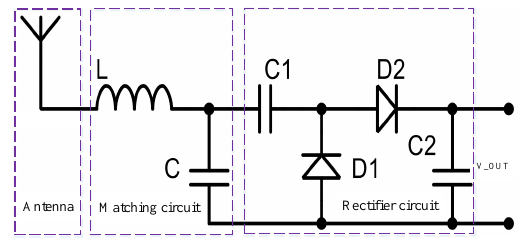
Figure 4. The scheme of the RF energy harvesting The antennas of the RF harvesting system capture the ambient radio frequencies in the environment. The densities of the radio frequencies are the main factor direct-a ff ecting the harvesting energy. Nowadays, the high RF densities are cell phones (900 MHz), WiFi sig- nals (5 GHz and others), local area networks (2.4 GHz- 5.8 GHz), radar (5 MHZ-130GHz), satellite stations (1- 40 GHz), and TV broadcast (500 MHz-700 MHz). The